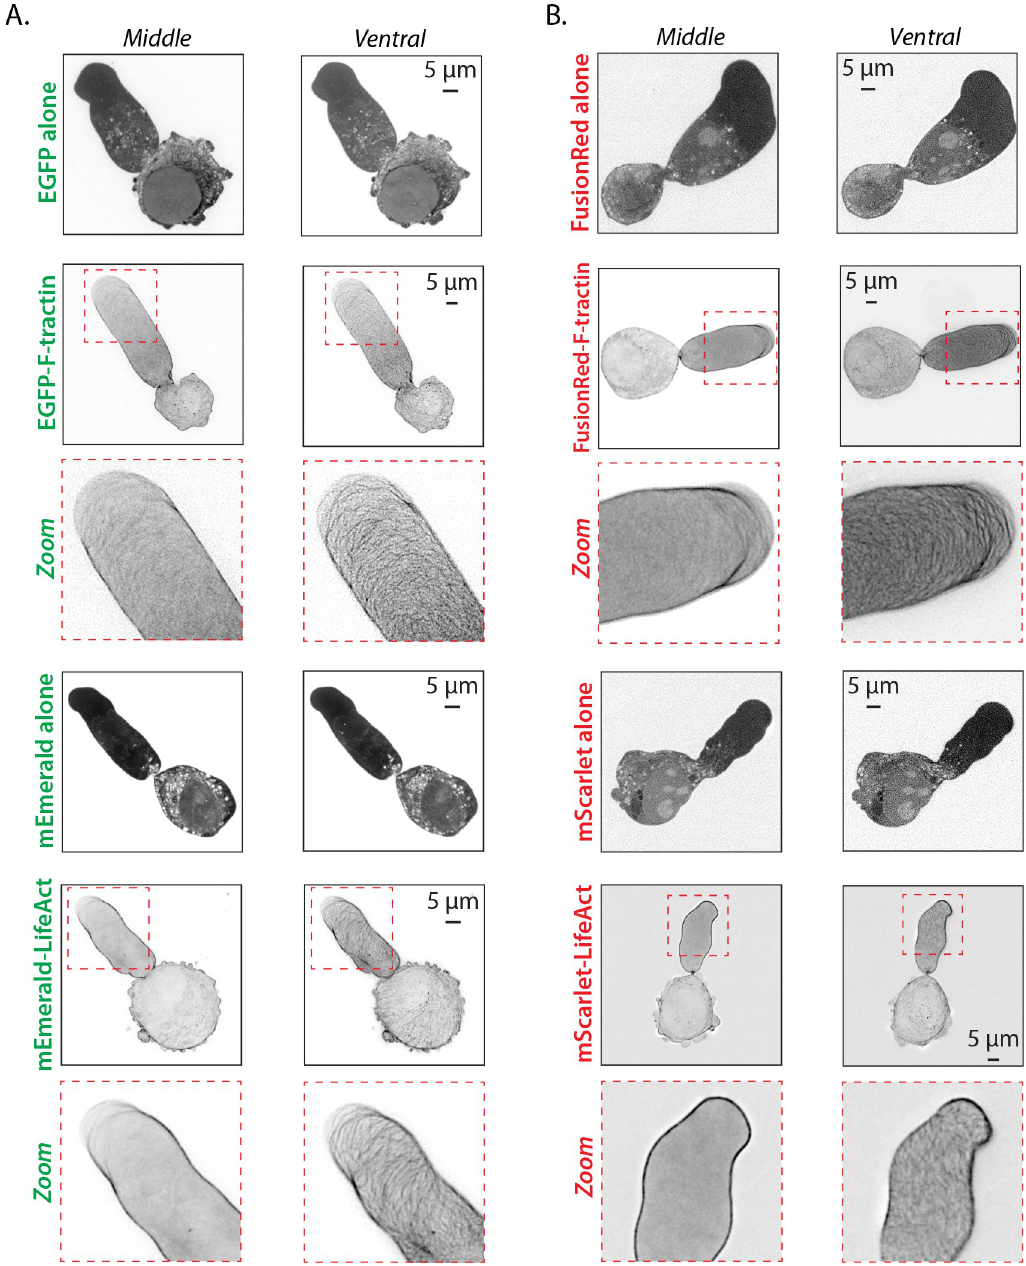
Fig 5. F-tractin and LifeAct mark the cortical actin cytoskeleton in leader blebs. A. Middle and ventral Z-sections of melanoma A375-M2 cells transiently transfected with EGFP alone, EGFP-F-tractin, mEmerald alone, and mEmerald-LifeAct. Zooms highlight the intricate cortical actin network in leader blebs. B. Middle and ventral Z-sections of melanoma A375-M2 cells transiently transfected with FusionRed alone, FusionRed-F-tractin, mScarlet alone, and mScarlet-LifeAct. Zooms highlight the intricate cortical actin network in leader blebs. All data are representative of at least three independent experiments. no leader (NL) cells upon staining with a membrane dye only, introduction of EGFP alone, EGFP-F-tractin, mEmerald alone, and mEmerald-LifeAct. This analysis revealed that the number of leader mobile (LM) cells was reduced upon transient transfection of EGFP-F-trac- tin, whereas the other conditions only moderately effected this number (Fig 6A). Strikingly,